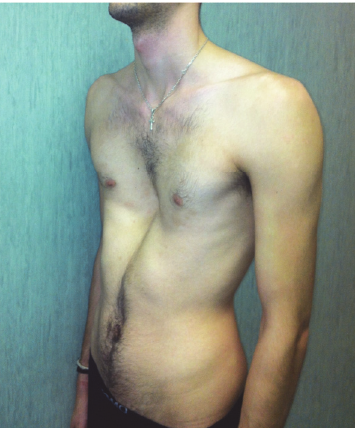
Figure 2: Severe pectus excavatum in a 29-year-old man affected by Marfan syndrome. The patient did not complain of any respiratory